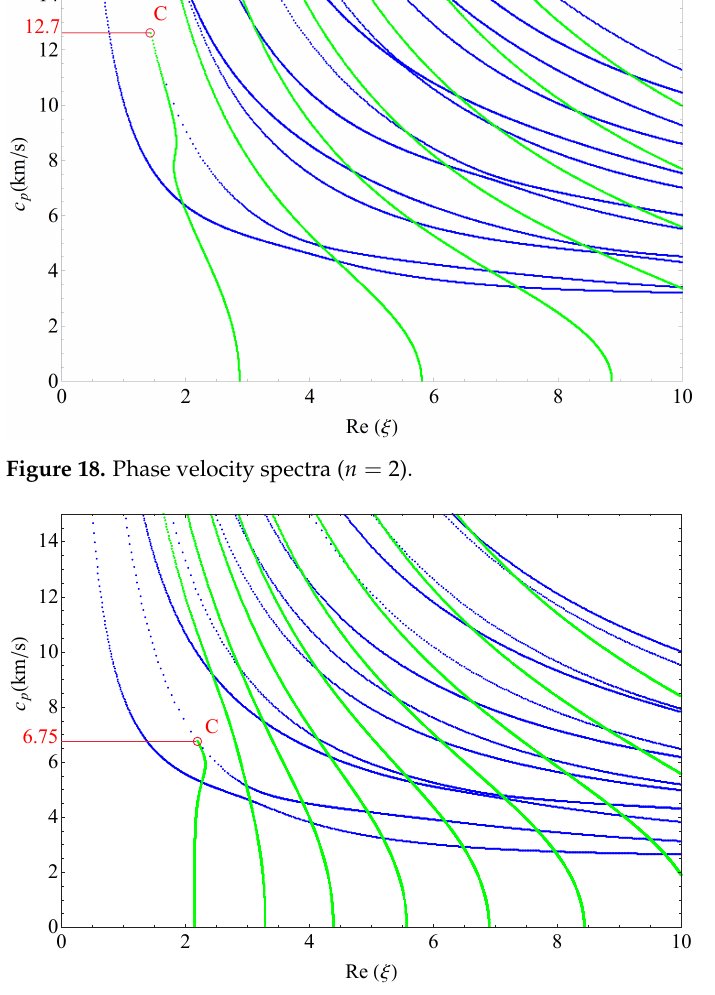
Figure 19. Phase velocity spectra without magnetic field ( n =